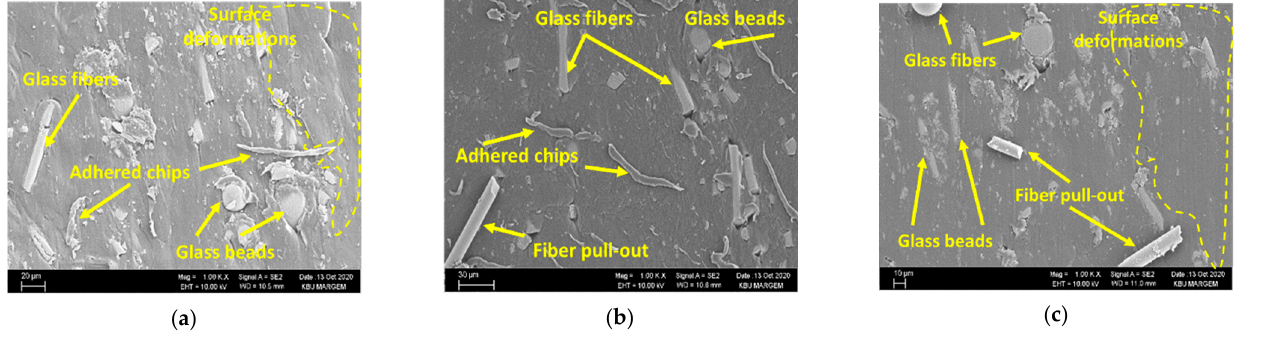
Figure 7. Hole surfaces of C3 for f = 0.05 mm/rev: ( a ) 30 m/min, ( b ) 45 m/min, ( c ) 60 m/min.